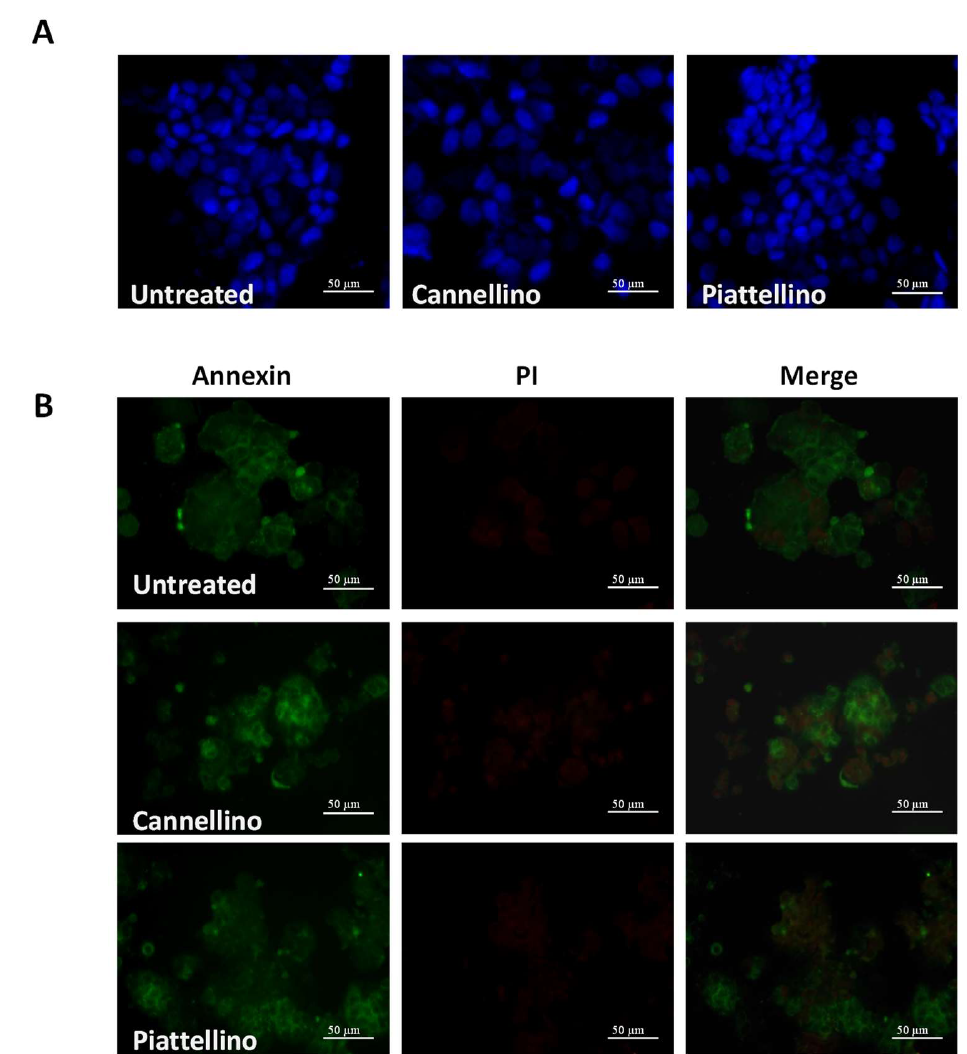
Figure 7. BF does not induce colon cancer cell death through the activation of apoptotic process. HT29 cells were incubated with 100 µ g/mL of Cannellino and Piattellino BF and stained with ( A ) 0.1 µ g/mL DAPI or ( B ) Annexin V-FITC conjugated antibody and Propidium Iodide. Data are representative of three independent experiments.